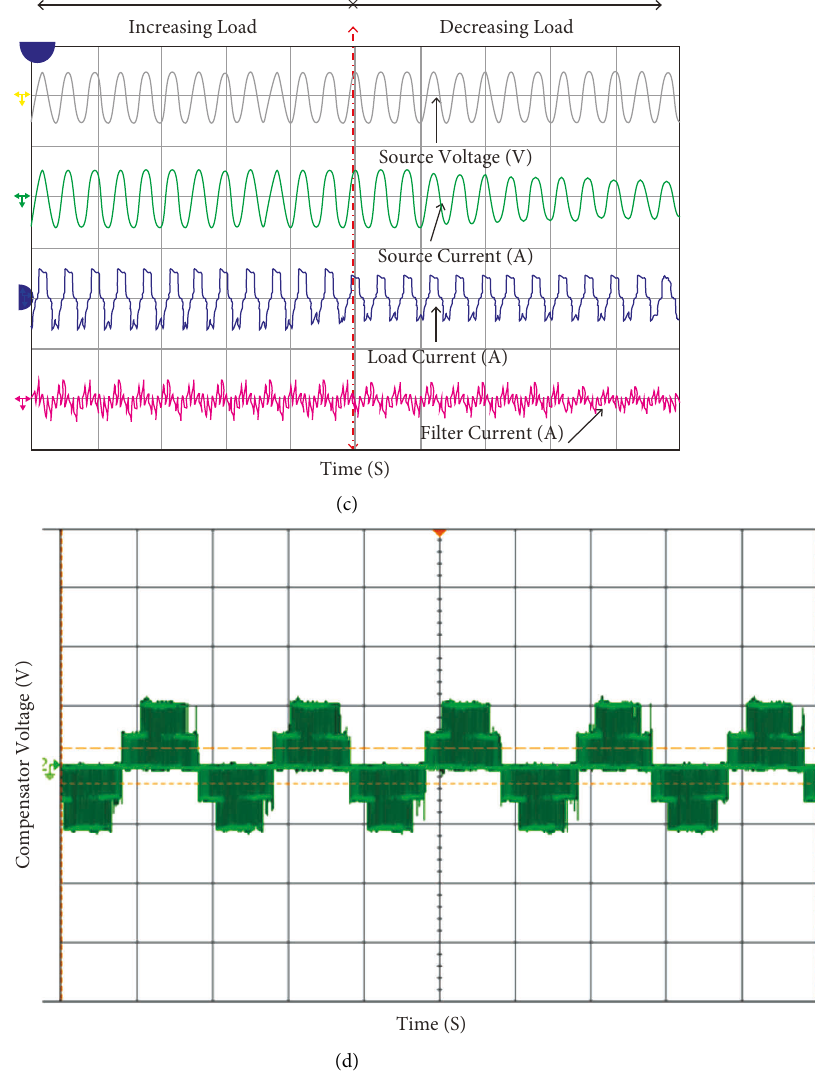
Figure 10: (a)Waveform of voltage and current before compensation, (b)waveform of voltage and current after compensation, (c)waveform of voltage and current for varying load conditions, and (d) waveform of filter